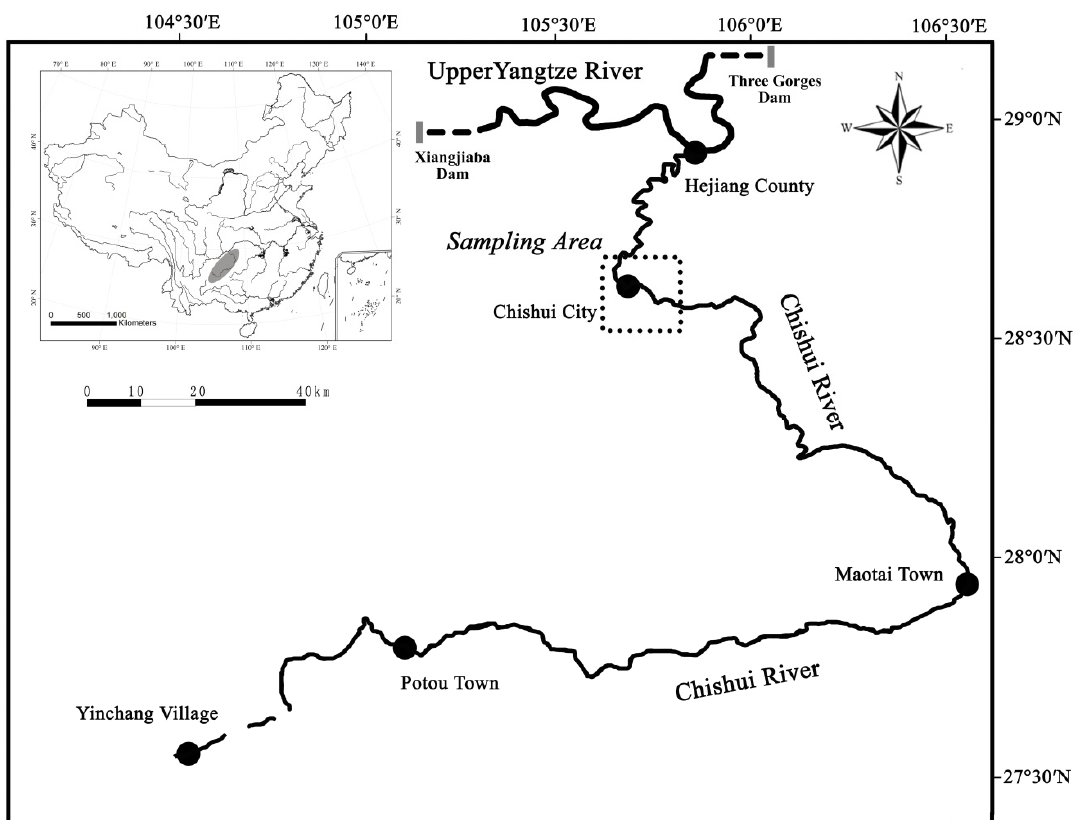
Figure 1. Map of study area (dashed box) in the Chishui River basin (shaded part). Dotted lines represent the simplification of the river reaches.